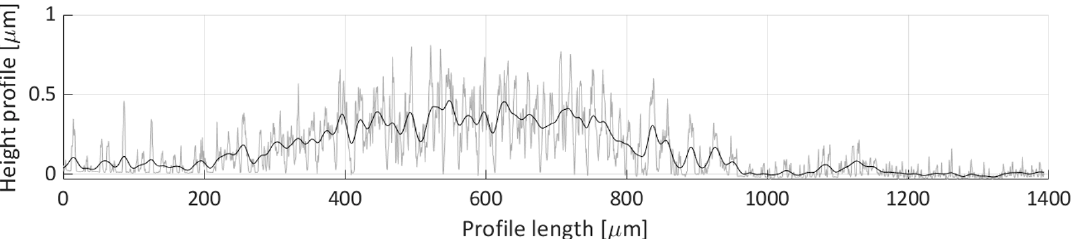
Figure 22. Height profile for the H2 line.